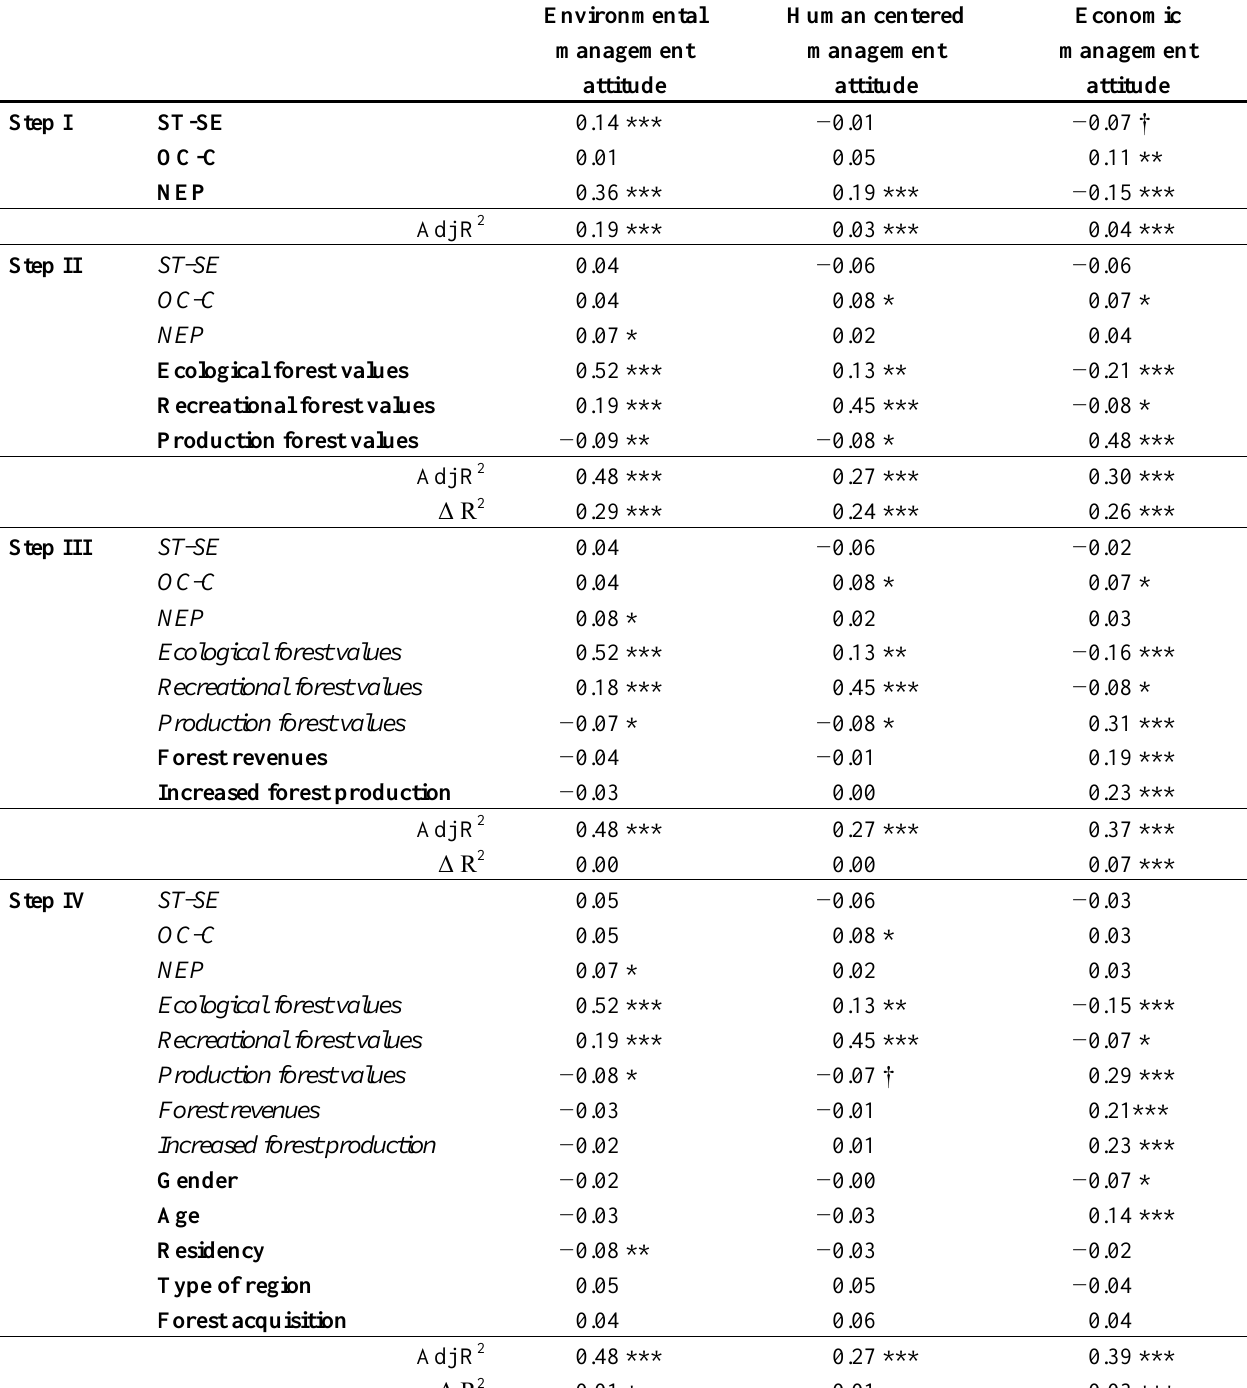
Table 4. Hierarchical regression with the influence of general values, environmental values, forest values, specific forest beliefs on three types of forest management attitudes (environmental, human centered, and economic), with beta